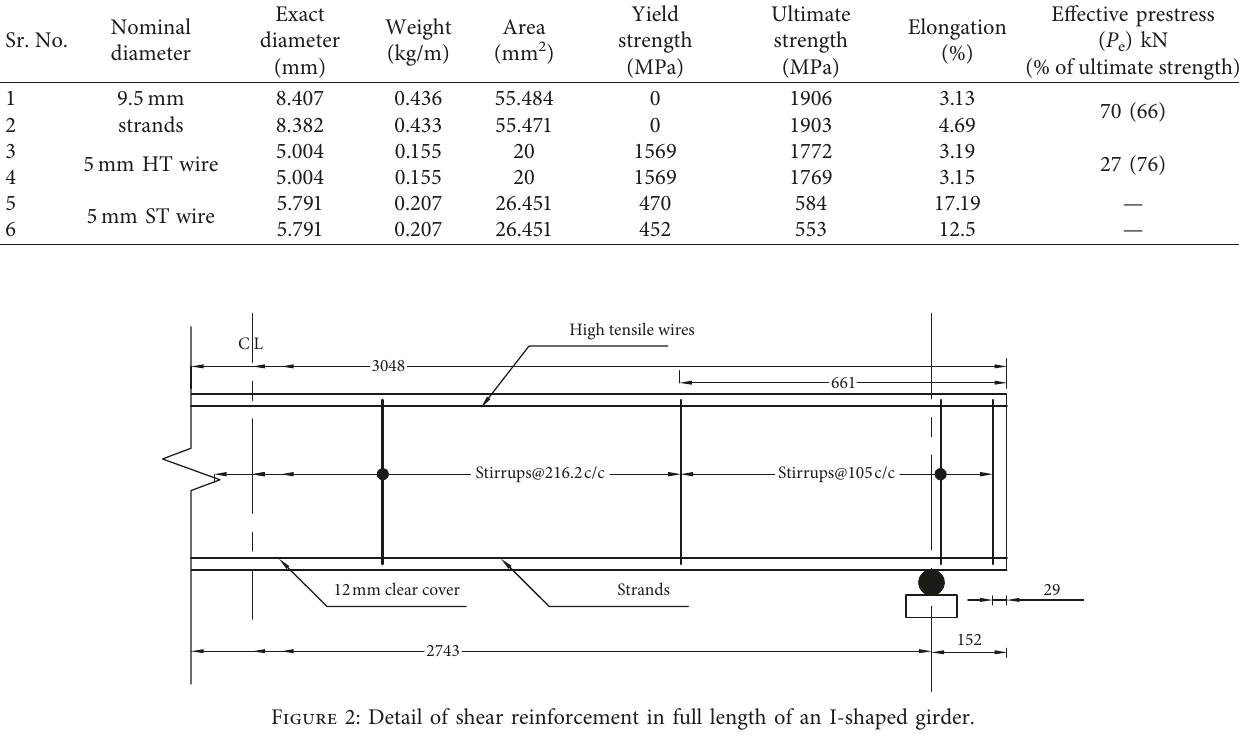
Table 2: Properties of prestresssing wires and detail of prestressing